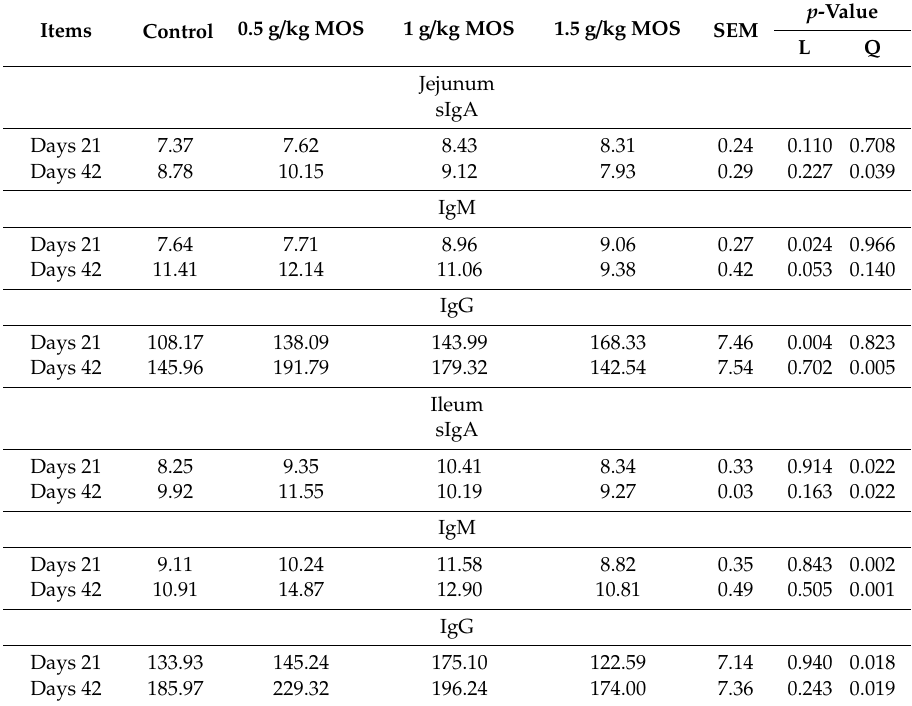
Table 5. Intestinal immunoglobulins contents of Partridge Shank chickens fed diets supplemented with or without MOS ( µ g / mg